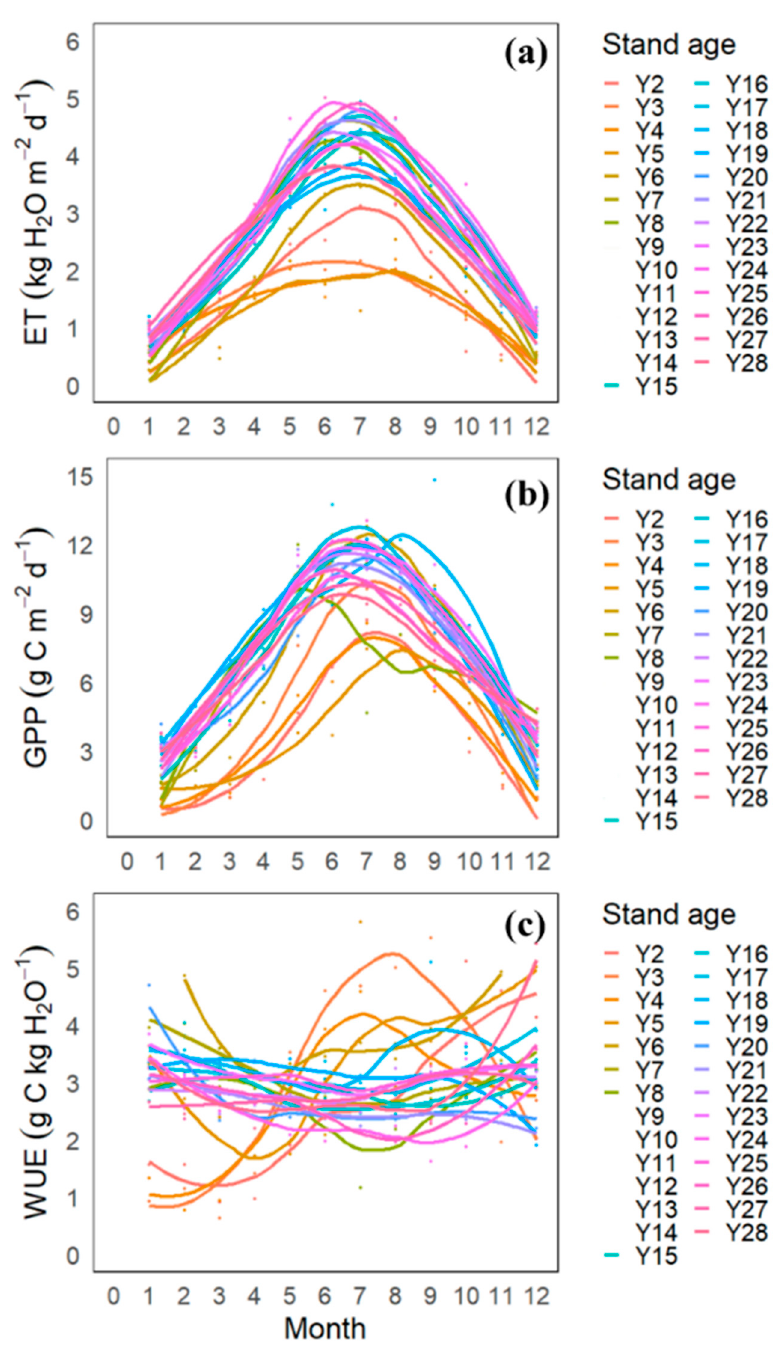
Figure 4. Seasonal trend in ( a ) evapotranspiration (ET), ( b ) gross primary productivity (GPP), and ( c ) water use efficiency (WUE) across different age levels of the chronosequence sites (YP and MP) based on monthly smoothed values for each year. Each year was assigned with different color. Smooth curve is represented by colored line and colored circles represent monthly data for each year.